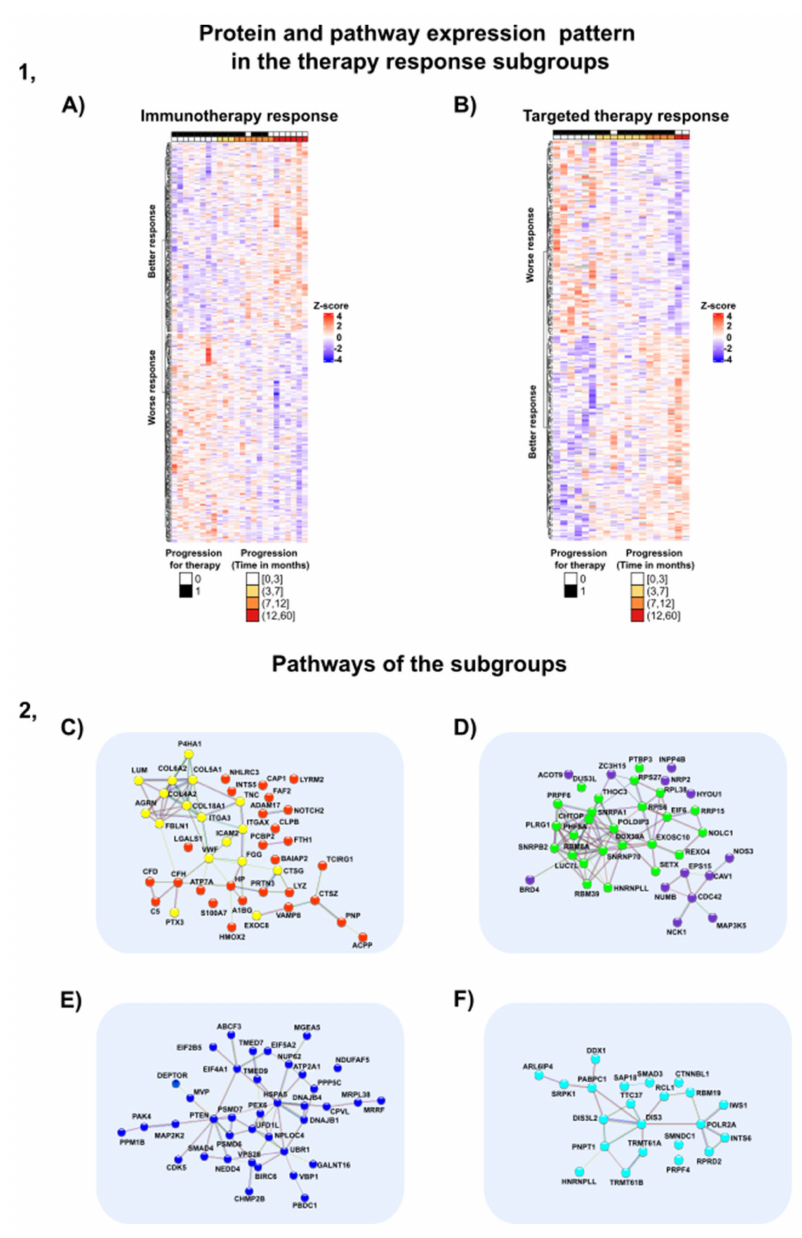
Figure 6. The heatmap of the treatment subgroups and the highlighted pathways. ( 1 ) Protein and pathway expression pattern in the therapy response subgroups. ( A ) Heatmap of the up- and downregulated proteins in patients with better and worse response in the immunotherapy subgroup. ( B ) Heatmap of the up- and downregulated proteins in patients with better and worse response in the targeted therapy subgroup. ( 2 ) Protein–protein interaction network of the up- and downregulated proteins in each treatment subgroup. ( C ) Proteins upregulated in patients with better outcome in the immunotherapy subgroup. The yellow color shows the extracellular matrix components, and red indicates the components from the immune system. ( D ) Proteins upregulated in patients with worse response in the immunotherapy subgroup. Proteins from the RNA processing are highlighted in green, whereas the purple color shows the members of the VEGFA-VEGFR2 pathway. ( E ) Proteins upregulated in patients with worse outcomes in the targeted therapy subgroup. The pathway analysis highlighted the key role of proteins involved in metabolic pathways. ( F ) Proteins upregulated in patients with better outcome in the targeted therapy subgroup. Multiple elements of RNA processing can be detected. The list of proteins involved in the aforementioned pathways is given in the Supplementary Document